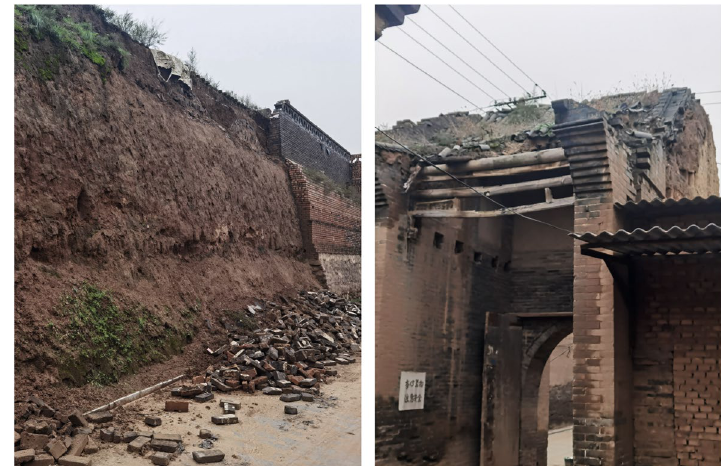
Fig. 3 Collapse of village wall and door roof of Liang Village (Source: Pingyao County